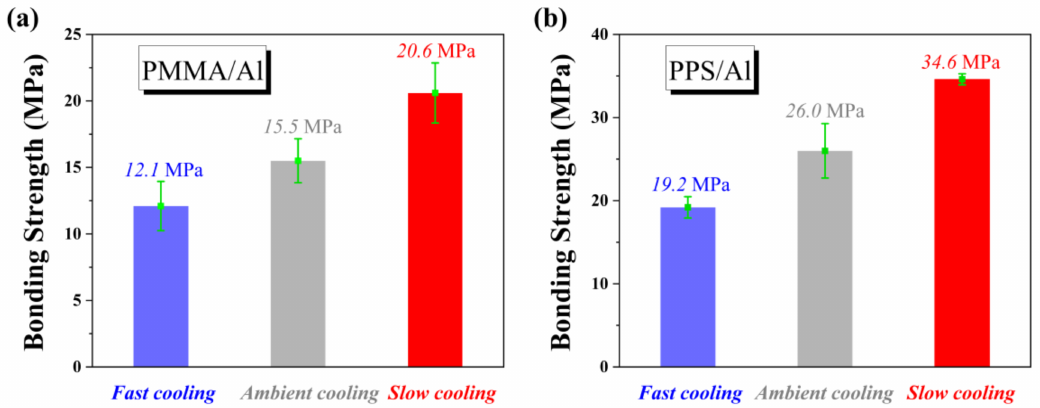
Figure 9. The cooling rate influence on the bonding strength of ( a ) PMMA/Al; ( b )